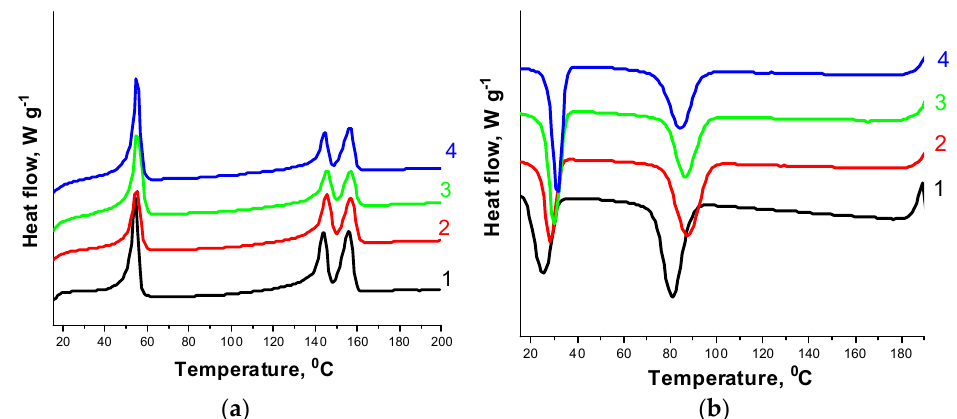
Figure 10. DSC curves for the PHBV/PCL(1:1) mixture (1); PHBV/PCL(1:1)/CNC(PVP)–5 (2), PHBV/PCL(1:1)/CNC(PVP)–10 (3), and PHBV/PCL(1:1)/CNC(PVP)–15 (4) composites: at heating ( a ); at cooling ( b ).